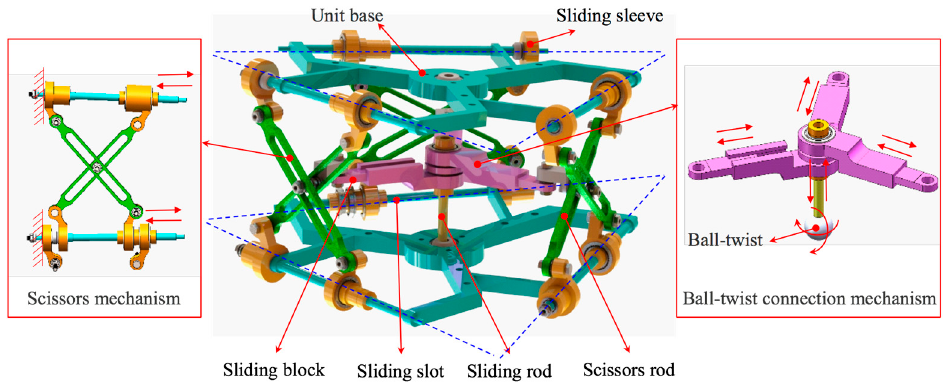
Figure 2. Model of scissor mechanism unit.